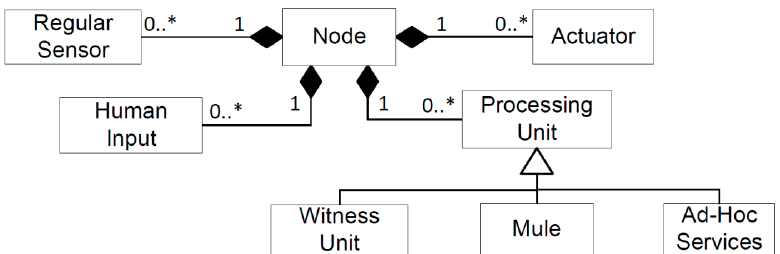
Figure 4. Roles composition for a